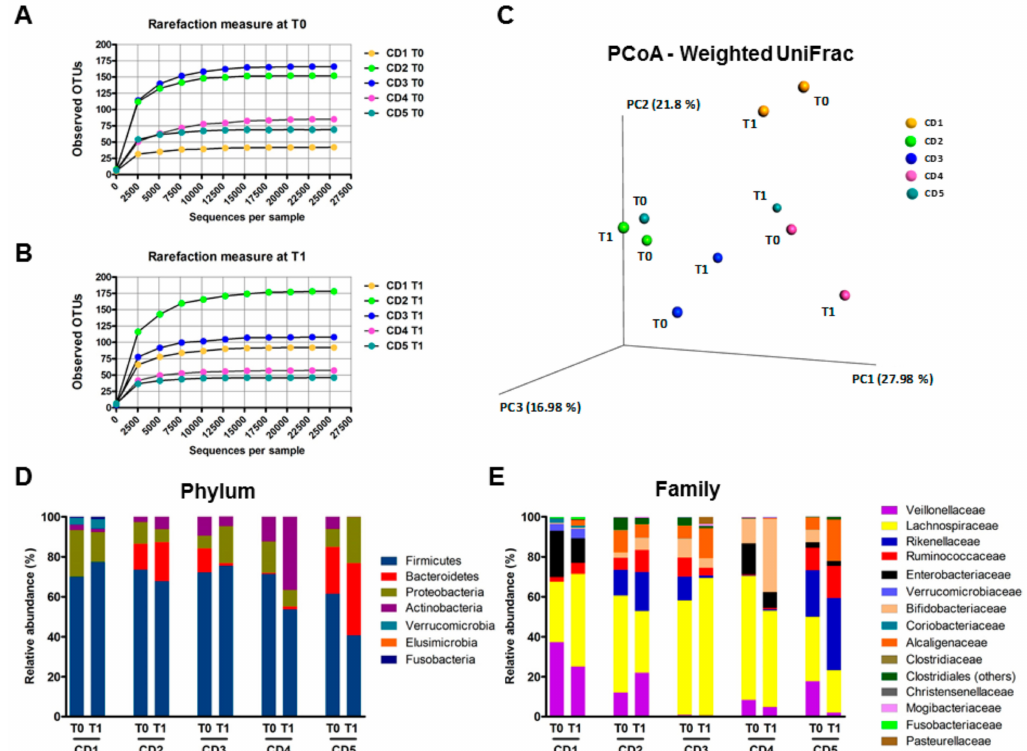
Figure 7. Fecal microbiota of Crohn’s disease patients was not modified following three subcutaneous injections with P28GST. ( A ) Rarefaction curves of observed OTUs as a function of reads demonstrated the great heterogeneity of microbiota among the patients at T0 and at T1 ( B ), n = 5. ( C ) Principal coordinate analysis (PCoA) of the fecal microbiota collected from 5 CD patients before and after P28GST injections using weighted UniFrac. Colors indicate samples from each individual. Comparison of beta diversity between before and after P28GST injections showed no significant di ff erence with PERMANOVA test ( p = 0.81, number of permutations 10,000). Individual relative abundances analyzed from 16S-based metagenomic sequences at the phylum ( D ) and at the family level ( E ) before (T0) and after achievement of the treatment protocol (T1) describe the well conserved distribution for each